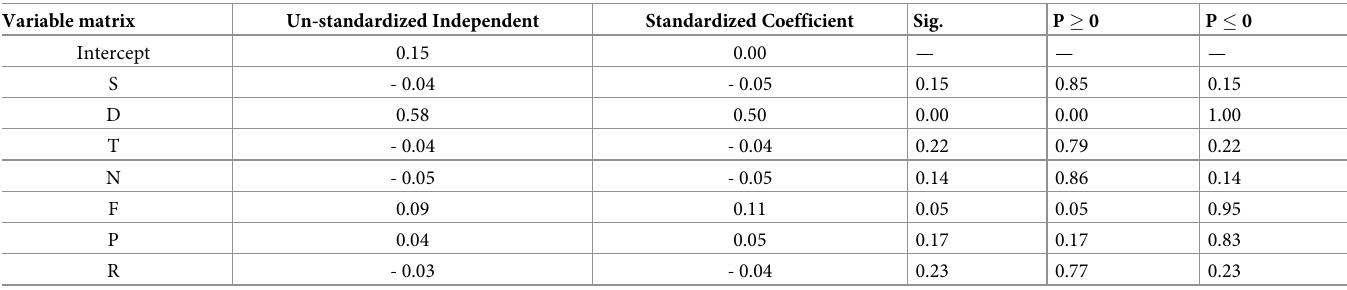
Table 5. Quantitative assignment procedure regression analysis results. Variable